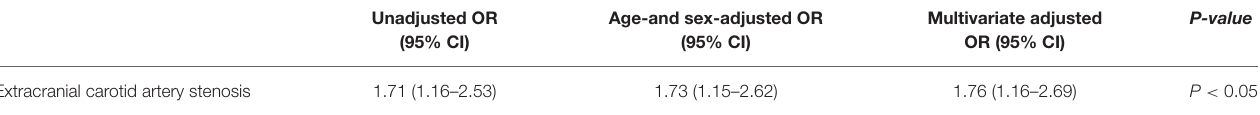
TABLE 3 | Correlation between total cSVD score and the severity of extracranial artery stenosis in multivariable ordinal regression analysis.